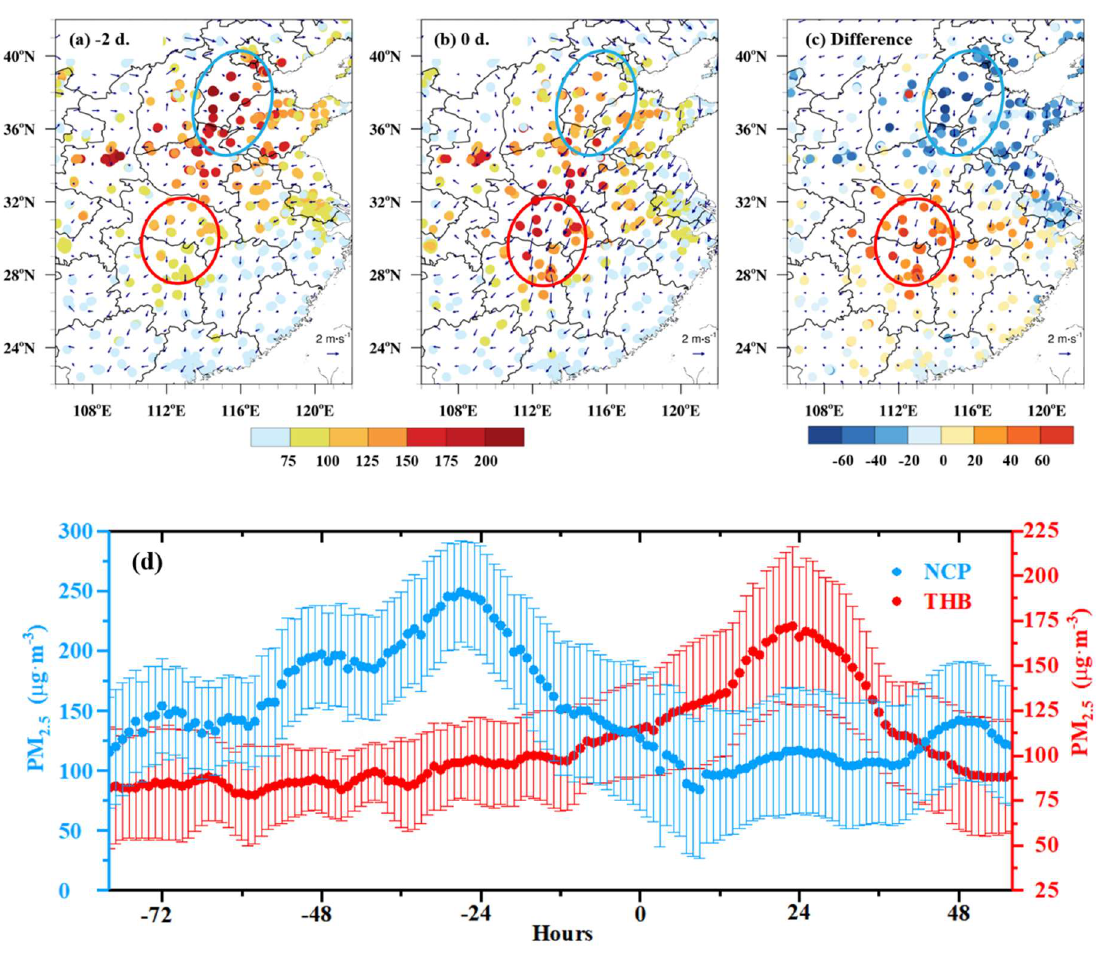
Figure 5. Distributions of PM 2.5 concentrations (scatter) and 10 m wind fields ( a ) 2 d before HPEs, ( b ) on HPE days over the THB, and ( c ) their differences, ( d ) hourly changes in surface PM 2.5 around the HPEs over the NCP and the THB, with the error bars representing the standard deviation.